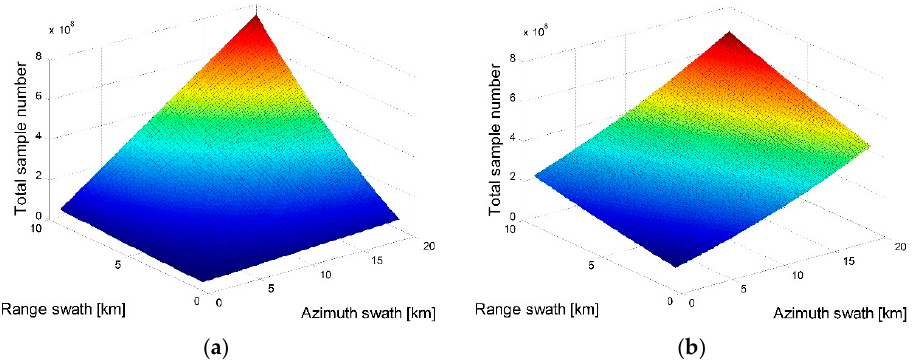
Figure 15. Total sample number variation of: ( a ) SSS-RSSAR; and ( b ) traditional sliding spotlight SAR with respect to the ROI swath.